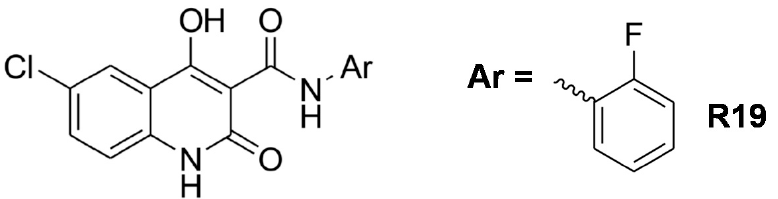
Figure 1. Chemical structure of the N-phenyl-6-chloro-4-hydroxy-2-quinolone-3-carboxamide series and R19 [9].